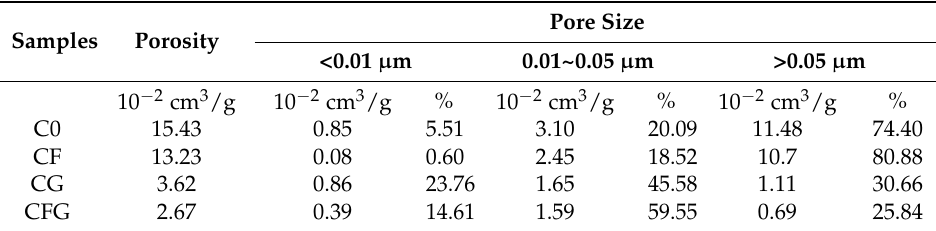
Figure 8. ( a ) Cumulative porosity; and ( b ) Log-differential volume curve plots. Table 3. Porosity and pore size distribution of